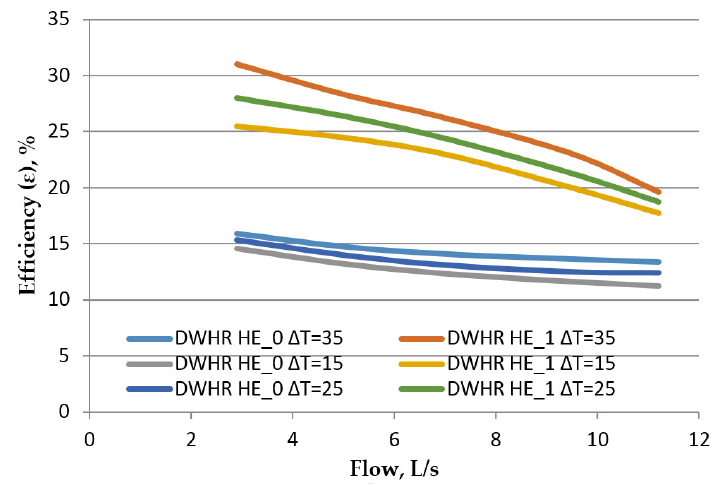
Figure 3. Efficiency of HE_0 and HE_1 (based on [40]). Figure 3. E ffi ciency of HE_0 and HE_1 (based on